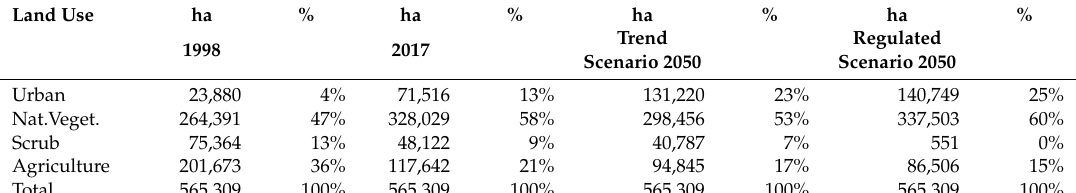
Table 7. Land use / cover of business-as-usual (BAU) and regulated scenarios by 2050. Table 7. Land use/cover of business-as-usual (BAU) and regulated scenarios by 2050.